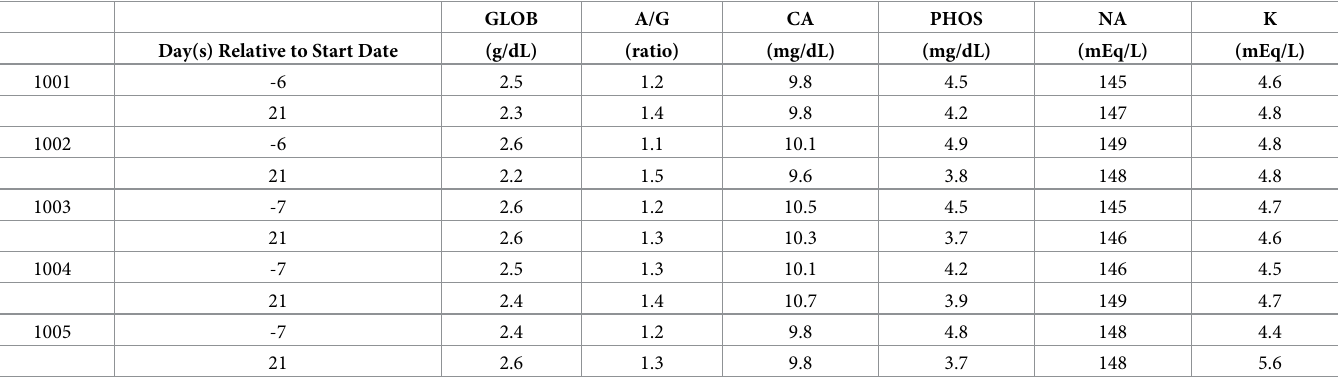
Table 6. Biochemistry reporting for each animal for GLOB, A/G, CA, PHOS, NA, K. GLOB A/G